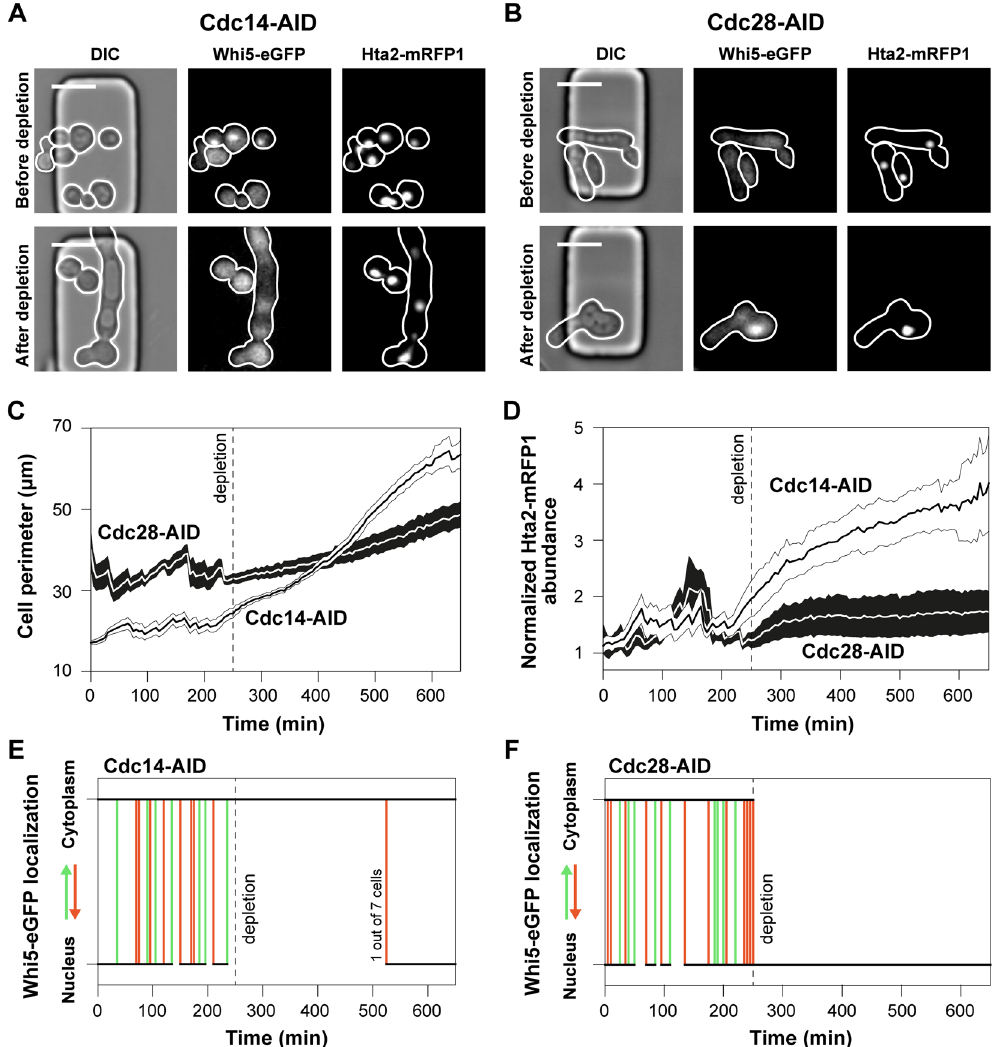
Figure 5. The auxin inducible protein degradation is efficiently used to deplete the Cdc14 and Cdc28 essential cell cycle regulators, and arrest the cell cycle at different phases. Microscopy images illustrate the phenotype of ( A ) Cdc14-AID and ( B ) Cdc28-AID cells prior and after protein depletion, including the cellular morphology, Whi5 localization and Hta2 abundance (scale 10 μ m). In the RFP channel the number of genome copies is also visible. ( C ) The average perimeter of Cdc14-AID (white) and Cdc28-AID (black) cells (shaded area: SEM), manually measured in each single cell (7 cells for each strain), and each individual frame, using the white cellular borderline in the DIC channel (as in Fig. 5A,B), prior and after protein depletion (at 250 min). ( D ) The average intracellular histone abundance (shaded area: SEM) is plotted over time (before and after protein depletion) for the Cdc14-AID (white) and Cdc28-AID (black) strains (7 single cells each). The histone abundance of each single cell, was divided over the histone abundance just after the first cytokinesis in the G1 phase, which corresponds to one copy of the genome, to estimate the number of genomes per cell. The generated polyploidy after Cdc14-AID depletion is also visible in microscopy images and the number of Hta2- mRFP1 foci (Fig. 5A – Hta2-mRFP1). ( E , F ) The single cell Whi5 localization dynamics upon the depletion of ( E ) Cdc14-AID or ( F ) Cdc28-AID. When the trajectory becomes vertical there is Whi5 translocation from the nucleus to the cytoplasm (bottom to top – green lines) or from the cytoplasm to the nucleus (top to bottom – red lines). When the lines are horizontal (black lines), Whi5 remains in the cytoplasm (top) or the nucleus (bottom). Whi5 is a cell cycle inhibitor and reporter of CDK activity 48–50 . In the G1 phase it is localized in the nucleus. At START, Whi5 is phosphorylated by the active Cln3/CDK complex and is being sequestered into the cytoplasm signaling cell cycle initiation and the G1/S transition. Whi5 re-enters the nucleus at late mitosis. ( E ) After Cdc14-AID depletion (dashed vertical line) and halting of the late cell cycle, the anaphase promoting complex is not activated to degrade the remaining cyclins. Thus, the Cdc14-AID depleted single cells maintain a constitutive CDK activity (Whi5 in the cytoplasm). Spontaneous degradation of cyclins occasionally leads to cell cycle completion (1 out of 7 cells). ( F ) Adversely, depletion of Cdc28-AID depletion (dashed vertical line) immediately causes Whi5 sequestration into the nucleus, reporting absence of CDK